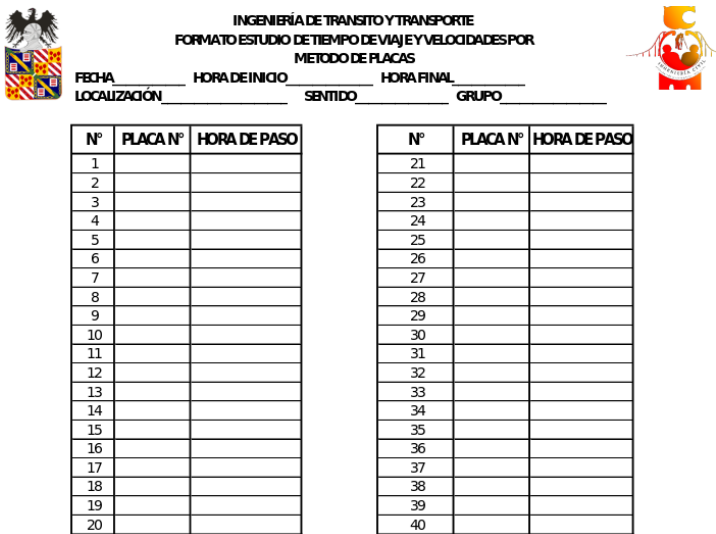
Figure 3: Measurement of practitioners with odometer, study format travel time and speeds by plate method, taking plates and times by practitioners.